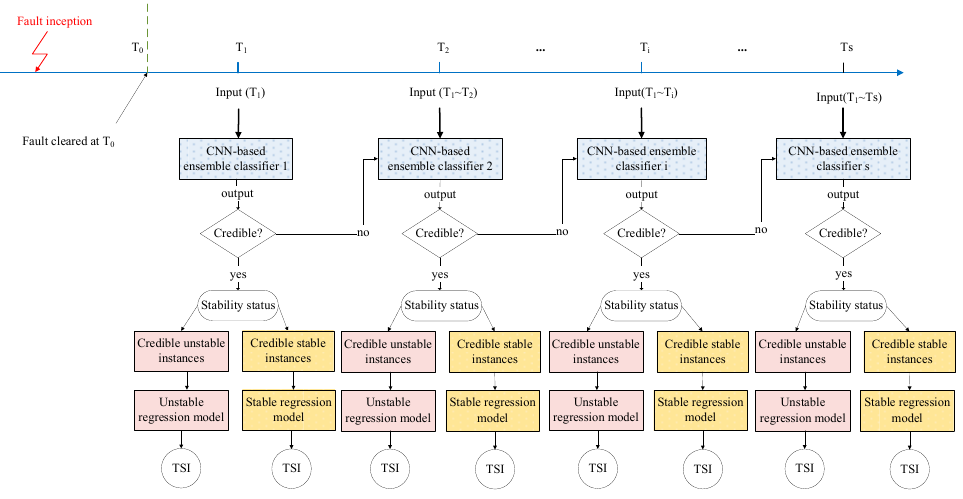
Figure 4. The process of the hierarchical self-adaptive CNN-based ensemble classifier for post-disturbance transient stability assessment (TSA).